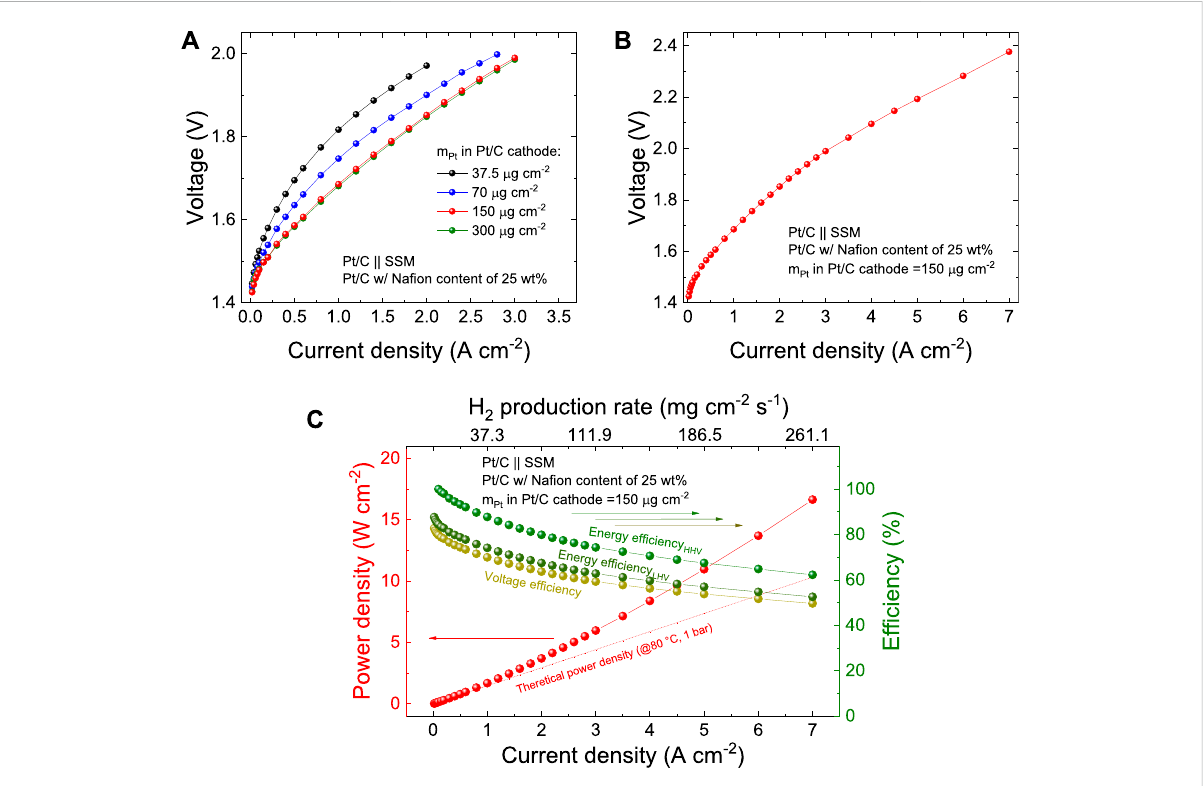
FIGURE 5 (A) GalvanostaticpolarizationcurveoftheAELbasedonPt/Ccathodesproducedwith25 wt%Na fi oncontentinthecatalystslayeranddifferent m Pt (from 37.5 to 300.0 μ g cm − 2 ). (B) Galvanostatic polarization curve, (C) power density and ef fi ciency metric ( i.e ., voltage ef fi ciency, energy ef fi